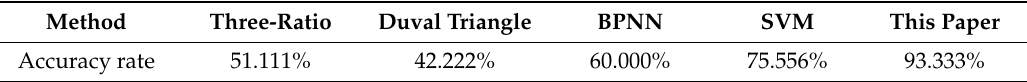
Table 2. Accuracy rate for the different diagnostic methods of transformer.